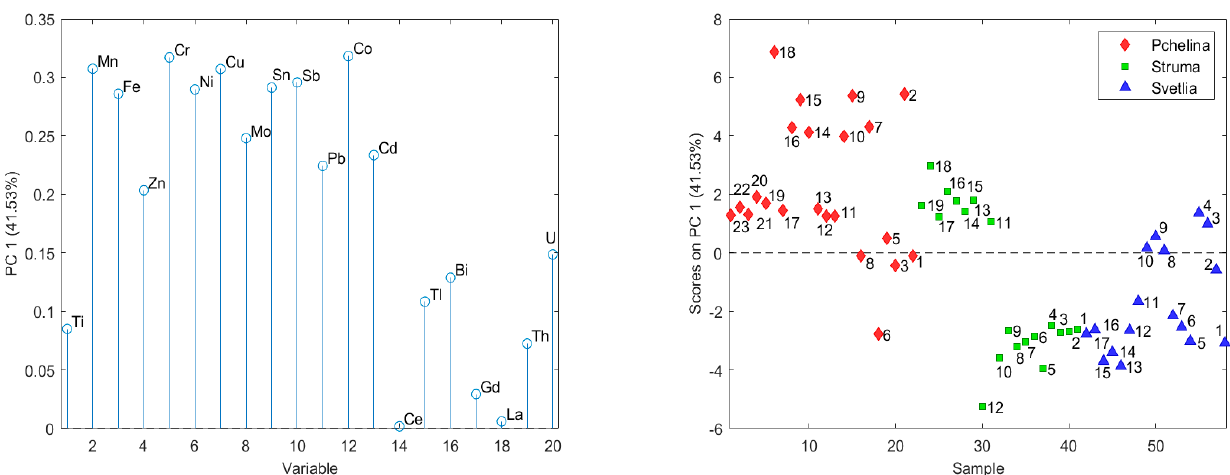
Figure 1. Factor weights and factor scores of the first principal components (the numbers on the graph indicate the historical sequence of layers in sediment core with the first (1) being the oldest).